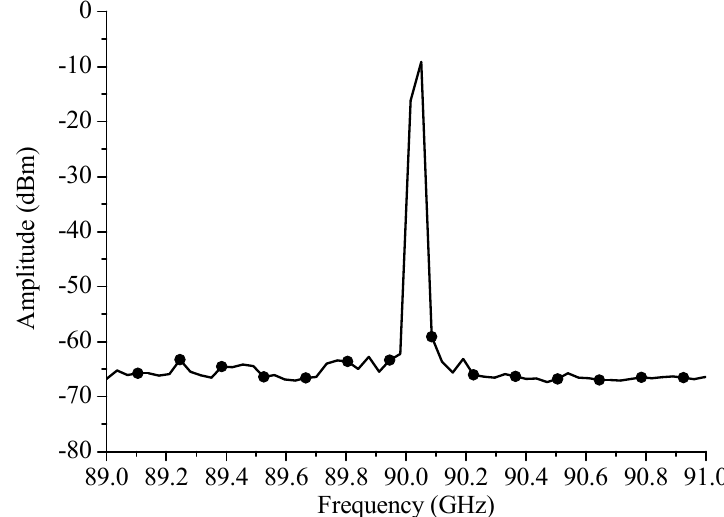
Figure 9. Measured output spectrum of the RTD oscillator.